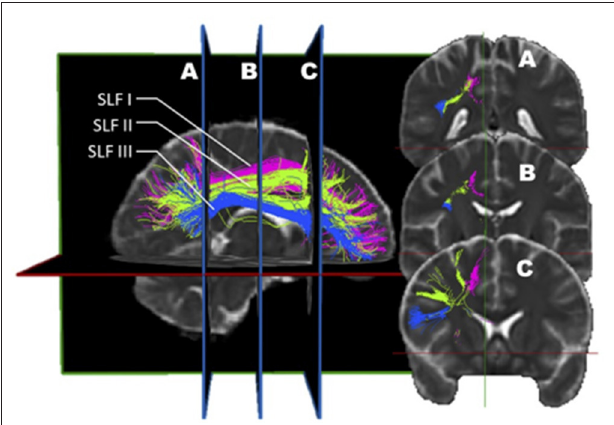
FIGURE 2 | In vivo fiber tractography of the right SLF I (pink), SLF II (green), and SLF III (blue). A three-dimensional reconstruction of the three segments of the SLF is displayed at the left of the figure. The coronal sections of it (A, B, and C) are represented on the right. The dorso-ventral as well as medio-lateral localization of each sub-segment can be visualized on the coronal